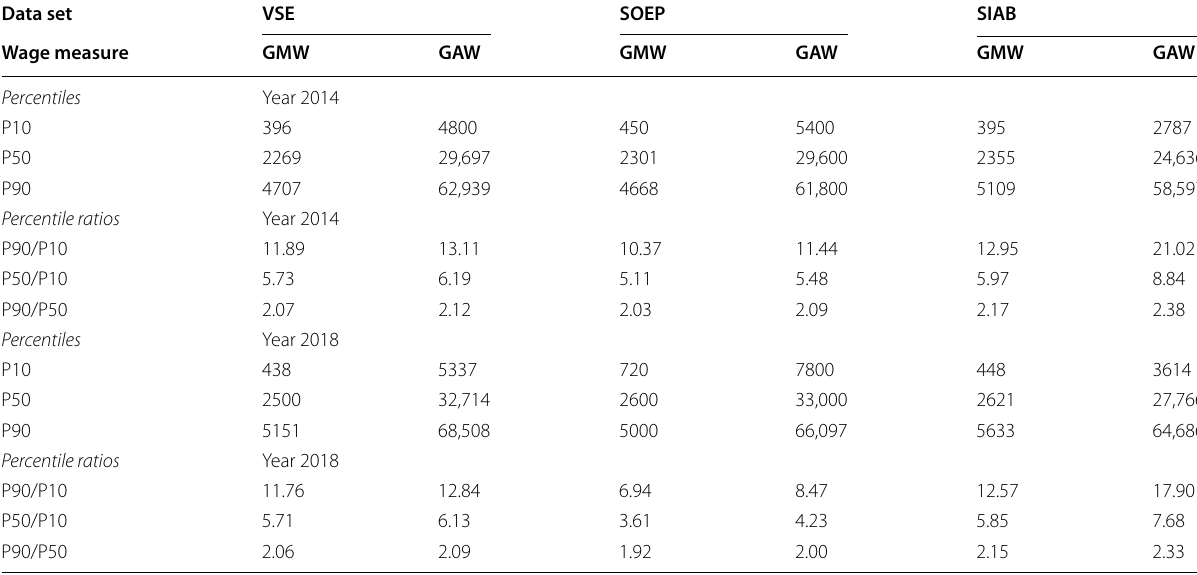
VSE Structure of Earnings Survey. GMW: gross nominal monthly wage in April. GAW: gross nominal annual wage. Total without apprentices. Economic sections A-S of the Classification of economic activities. Thus, not considered is employment in sectors T (Private households with employed persons) and U (Extraterritorial organizations and bodies). Source: Statistisches Bundesamt (2016, 2020) SOEP Socio-Economic Panel (SOEP-Core.v37.EU, own calculations). GMW: gross nominal monthly wage (SOEP-Pure 1). GAW: gross nominal annual wage (SOEP-Pure